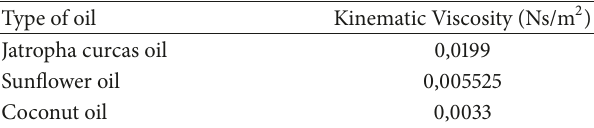
Table 4: Viscosity at room temperature.